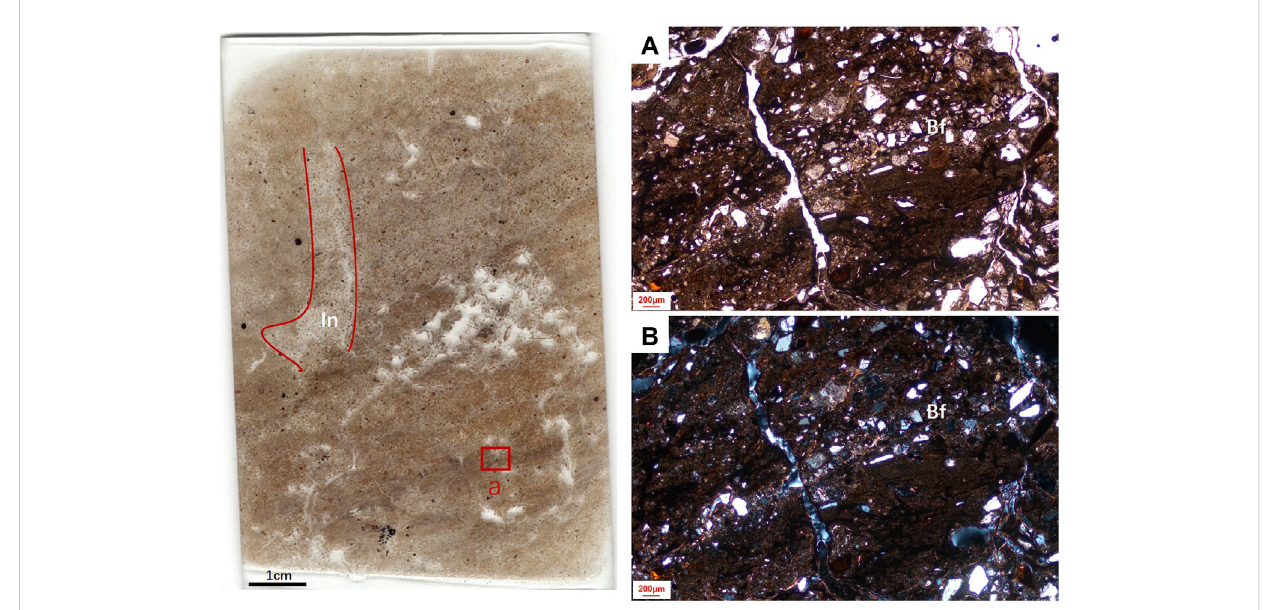
FIGURE 6 ScanofthethinsectionfromblocksampleDD7;theupperfabricismainlycomposedof fl uvialsands,verticallongcrackslater fi lledbycoarsesiltand fi ne sand (In) are marked by red lines; the lower fabric is fi ner and darker. (A) and (B) : banded fabrics related to alternating freeze and thaw (PPL and XPL), Bf: banded fabric.